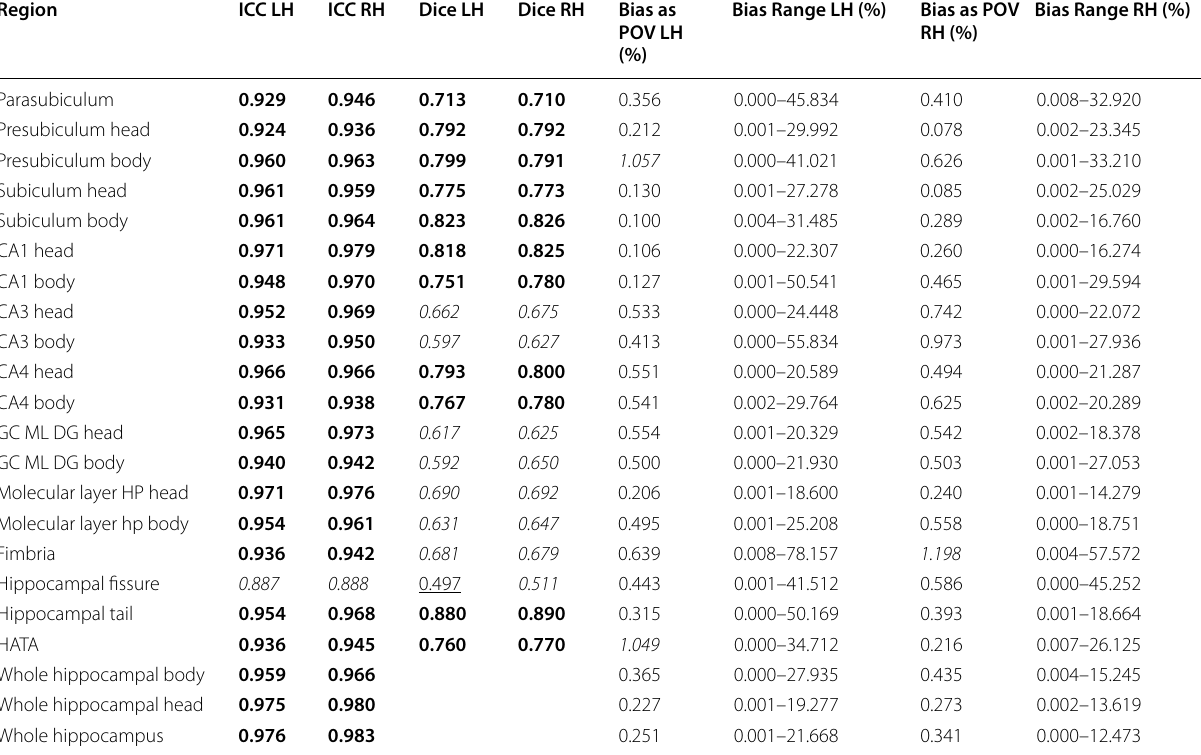
Table 1 Intraclass correlation coefficients (ICC), Dice coefficients, Bland–Altman bias as a portion of a volume’s structure (bias as POV), and Bland–Altman bias ranges for Hippocampal Subfields for left and right hemisphere regions (e.g., ICC LH coefficients for left hemisphere; Dice RH Dice coefficient for right =